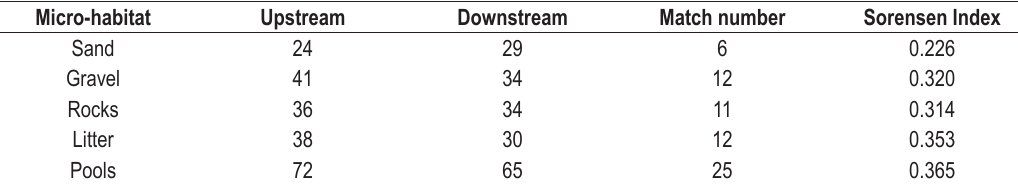
Table 2. Similarity by microhabitats and total similarity between the pools.